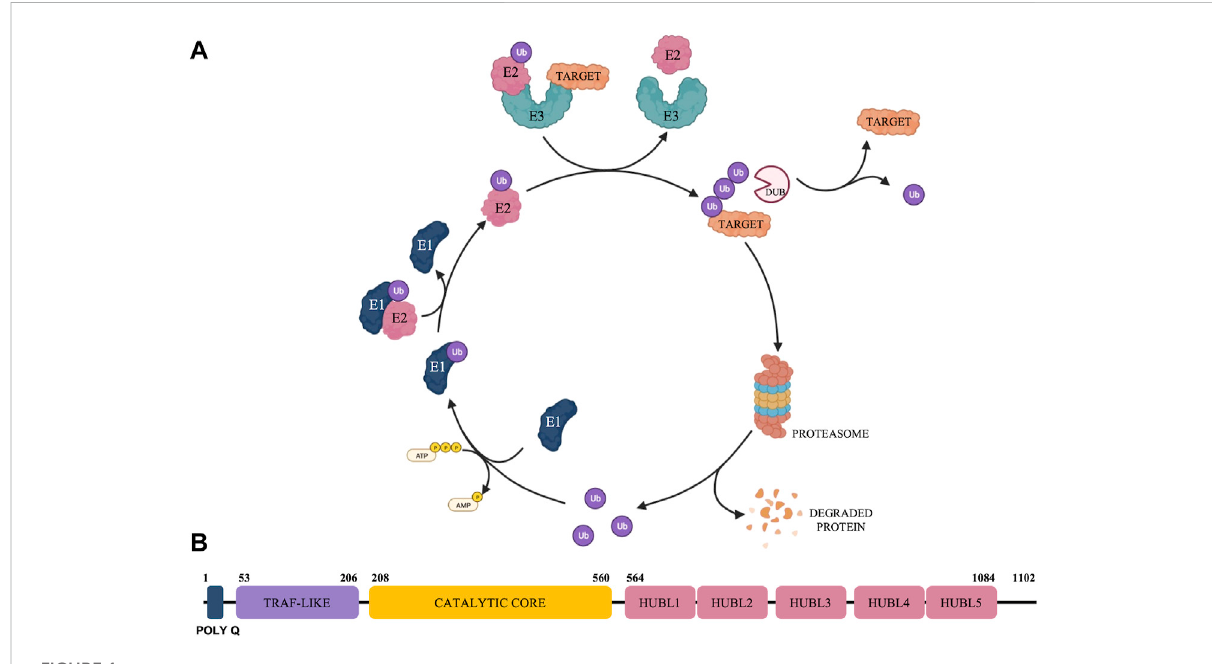
FIGURE 1 Schematic representation of the Ubiquitin Proteasome System (A) and overview of USP7 structure (B) .